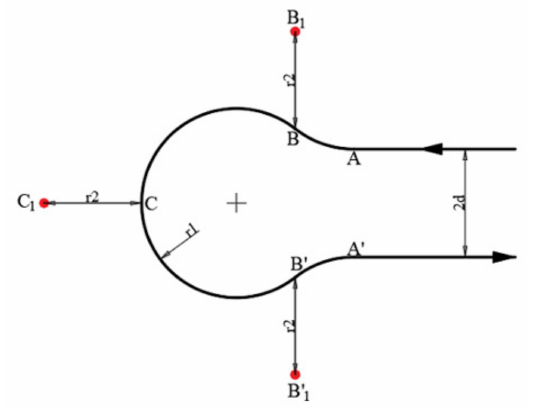
Figure 8. Dubins path (RLR) with the waypoint radius taken into consideration, which is deemed to increase the turning performance, resulting in a better trajectory.